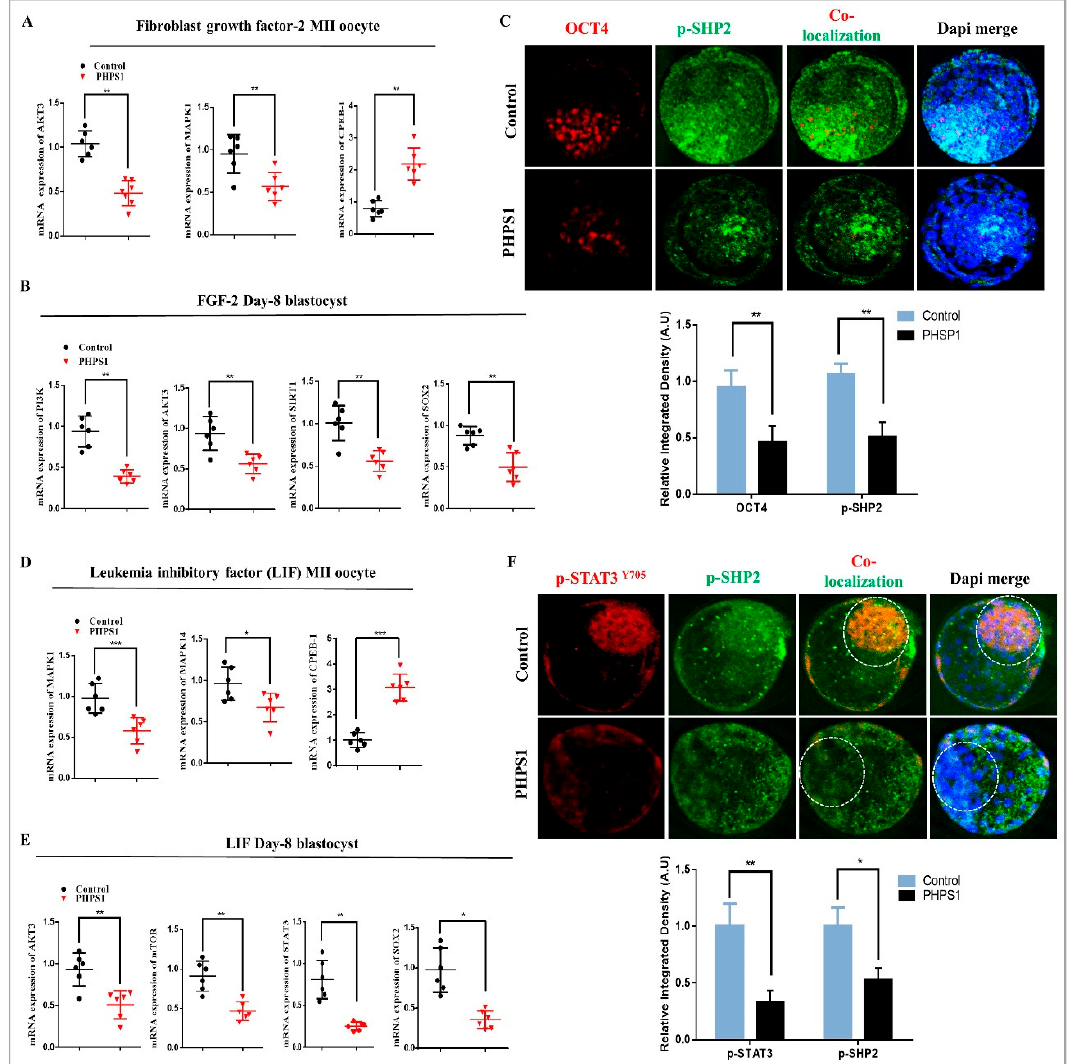
Figure 5. SHP2 dependent RTKs and Cytokines signal transduction. ( A ) FGF2 and PHPS1 treated groups showing relative mRNA expressions of AKT3, MAPK1 and CPEB1 in oocytes (n = 20 per each group). ( B ) FGF2 and PHPS1 treated groups showing relative mRNA expressions of PI3K, AKT3, Sirt1 and SOX2 in blastocysts (n = 5 per each group). ( C ) Immunofluorescent co-localization of